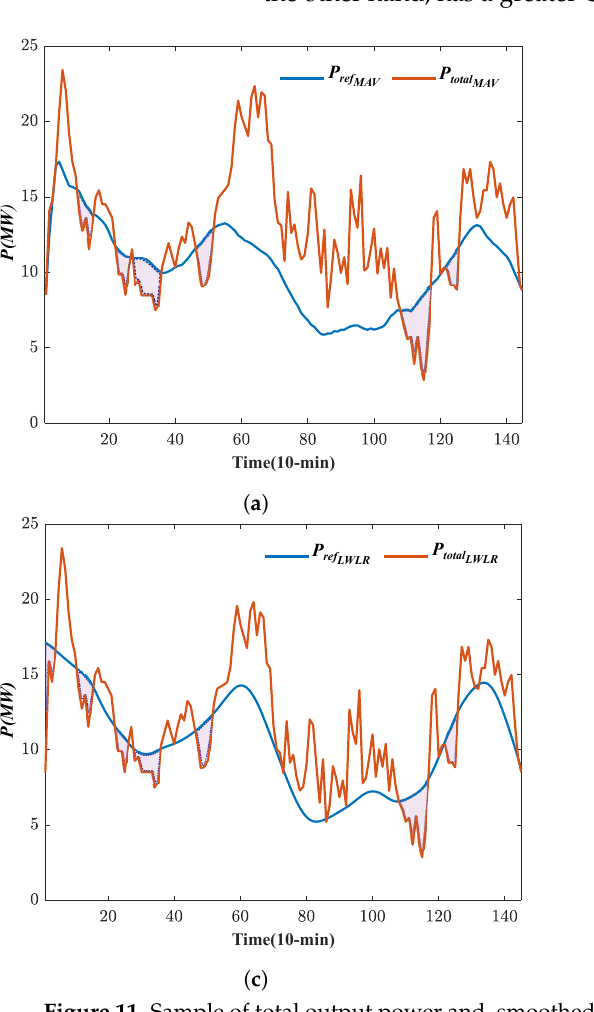
Figure 11. Sample of total output power and smoothedwind power: ( a ) MAV; ( b ) Gaussian; ( c ) LWLR; ( d )